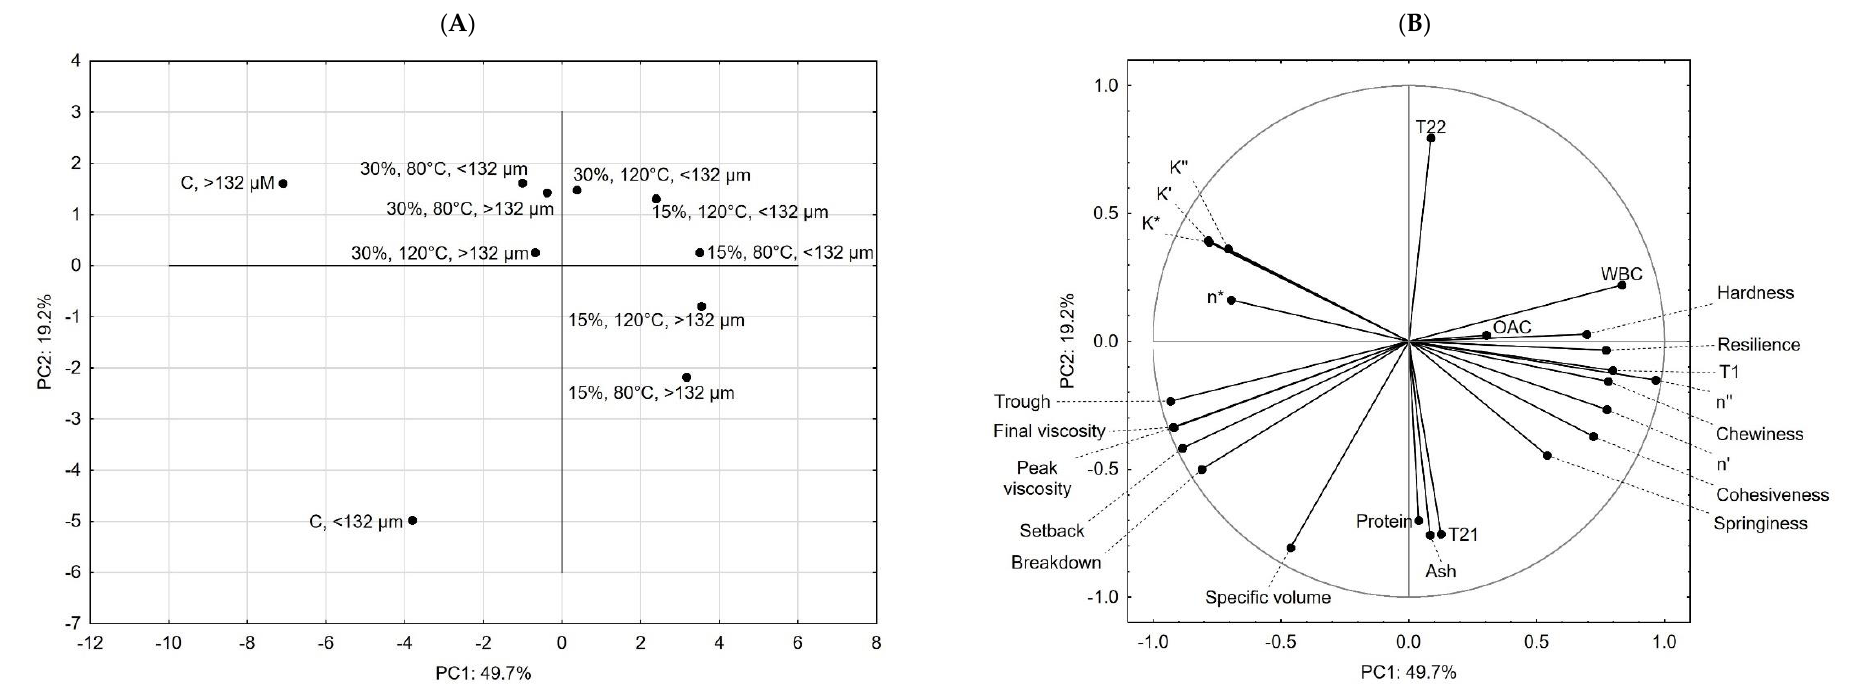
Figure 3. PCA of score plot ( A ) and loading plot ( B ) of physicochemical, mechanical, and molecular properties of analyzed rice flours.